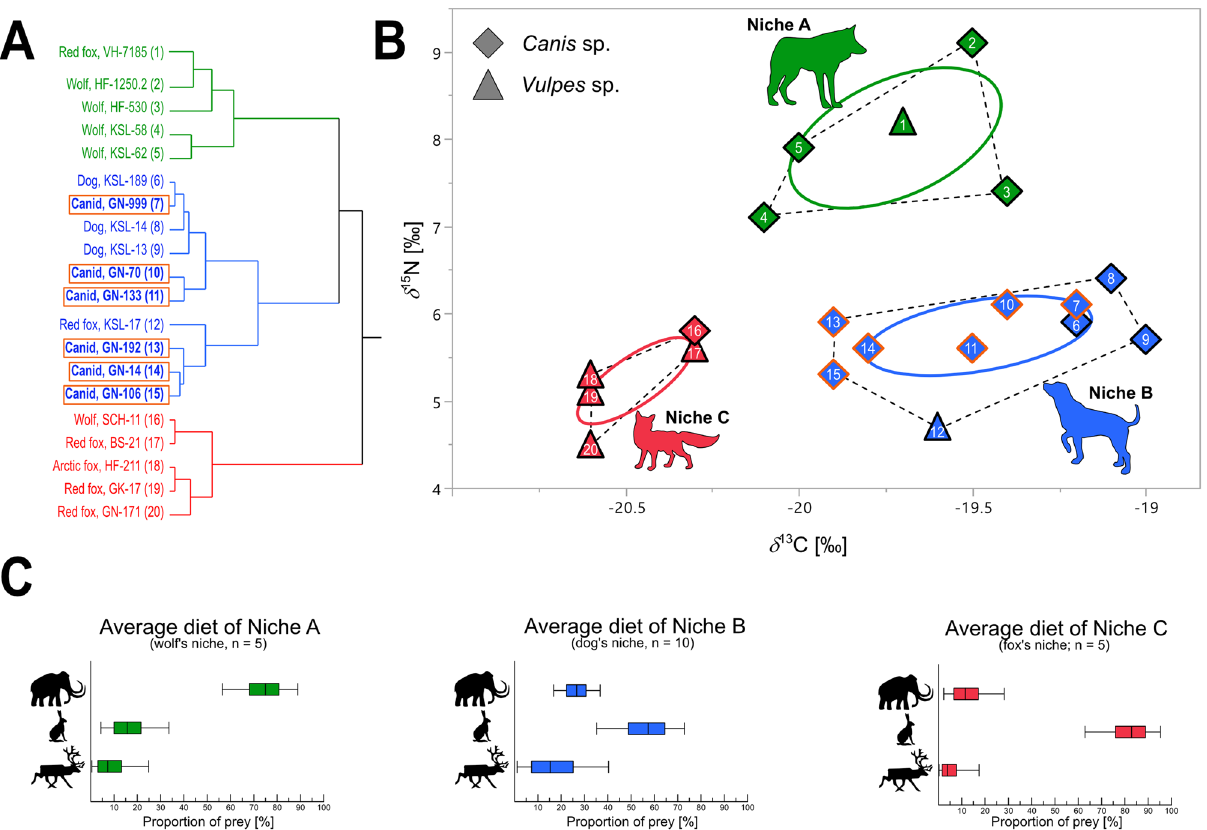
Figure 3. (A) Cluster analysis of stable isotopic values of the canids. (B) Reconstructed trophic niches and (C) dietary reconstruction of the ancient Magdalenian canids based on stable isotope data of carbon and nitrogen preserved in bone collagen. Labels of the new samples from this study are in bold and marked with an orange rectangular frame. Numbers in (B) correspond to these in (A)